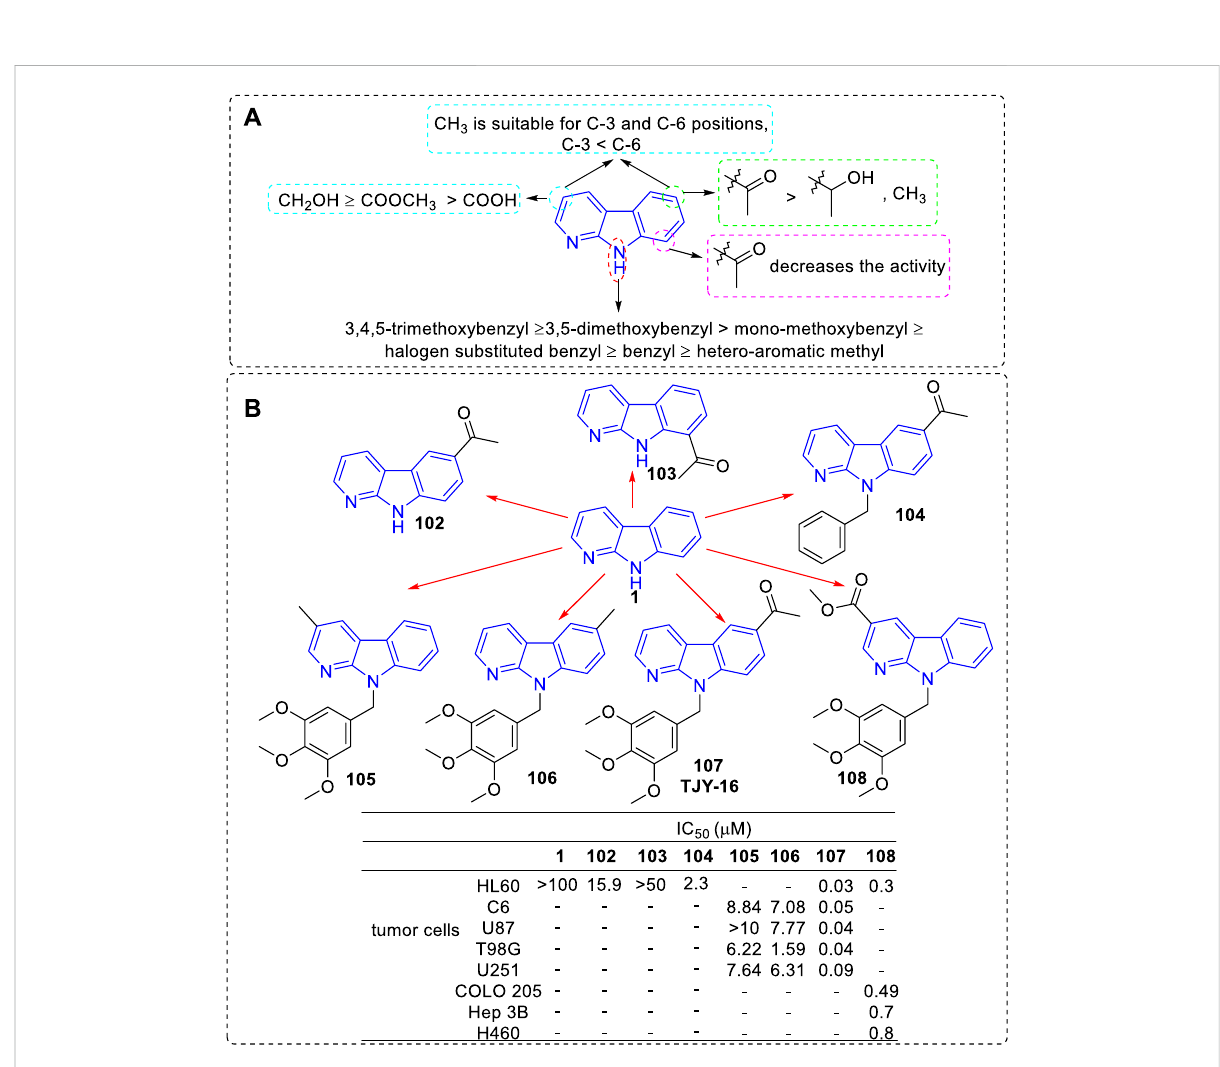
FIGURE 18 (A) SARs of 3, 6, 8, or 9-substituted α -carbolines for their antitumor activity; (B) Structures and bioactivity of the representative compounds 102 – 108